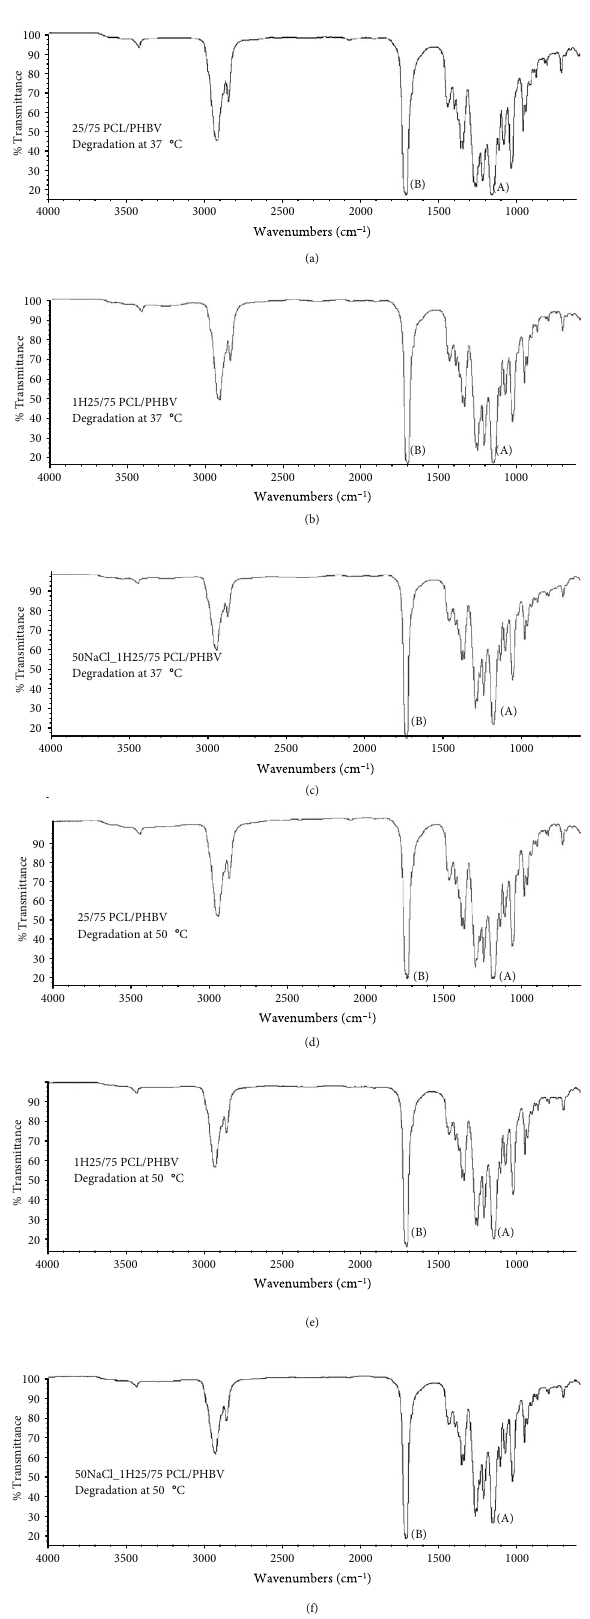
Figure 9: Infrared spectra of (a) 25/75, (b) 1H25/75, and (c) 50NaCl_1H25/75 PCL/PHBV after 30 days of degradation in phosphate bu ff er at 37 ° C and the same sca ff olds in (d), (e), and (f) at 50 ° C,